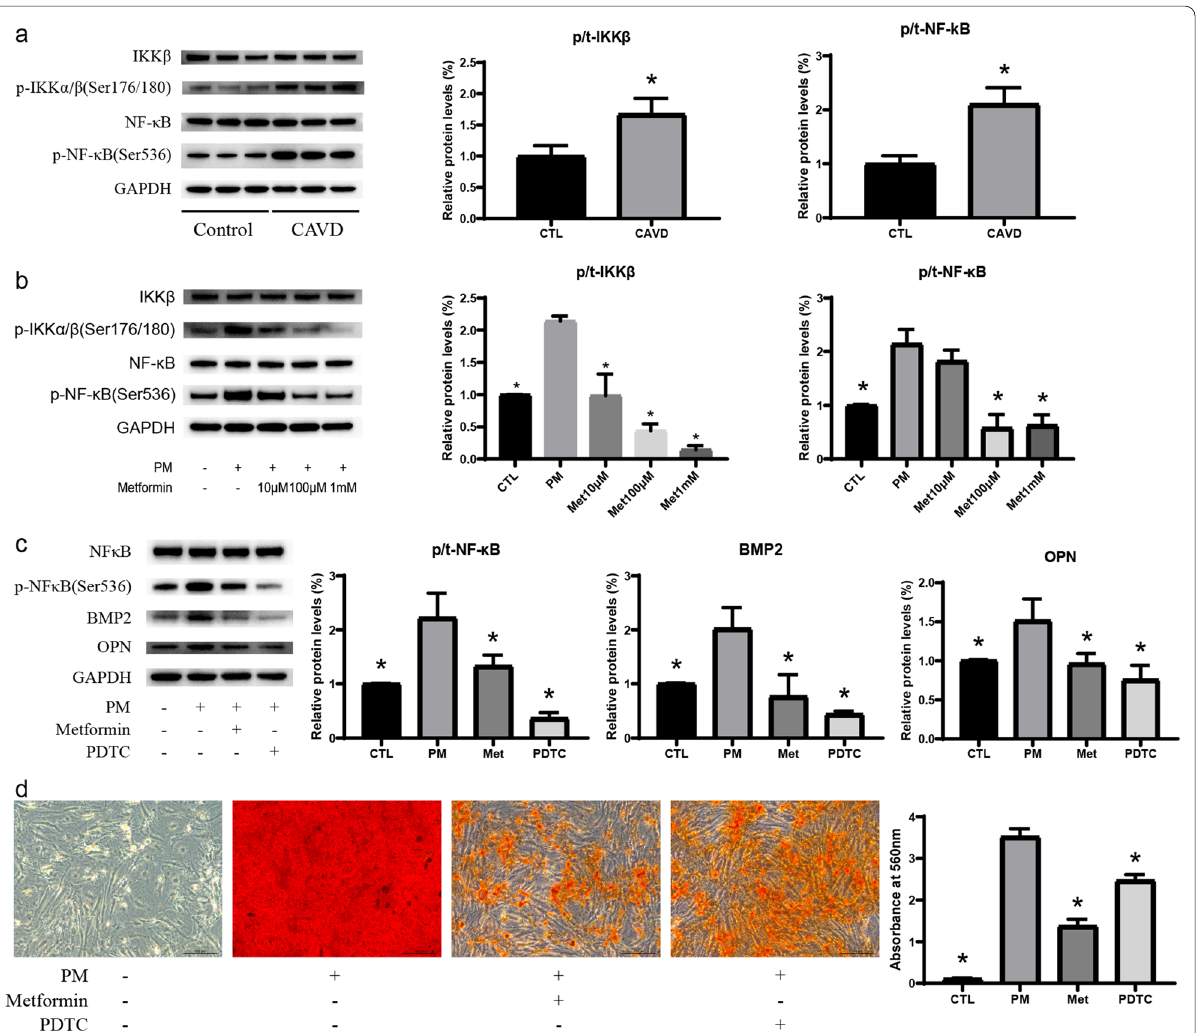
Fig. 6 The anti-calcification effect of metformin is related to NF-κB inhibition. a Protein expression levels of p-IKKα/β (Ser176/180) and p-NF-κB (Ser536) of control (n 9) and calcific (n 8) valves were determined by WB, *p < 0.05 versus control group (Student’s t-test); b the protein = = expression of p-IKKα/β (Ser176/180) and p-NF-κB (Ser536) in AVICs after PM treatment with or without metformin for 72 h as determined by WB, n 3 per group; c protein expression levels of p-NF-κB (Ser536), BMP2, and OPN in AVICs after various treatments with metformin (100 μM) and = NF-κB inhibitor (PDTC, 10 μM) for 72 h as determined by WB, n 3 per group; d, Calcium deposition were detected by ARS Staining after various = treatments for 7 days, Scale bar, 200 μm, n 6 per group. CTL control; PM phosphate medium; Met, metformin; CAVD, calcific aortic valve disease; = *p < 0.05 versus PM group (one-way ANOVA with Bonferroni post hoc